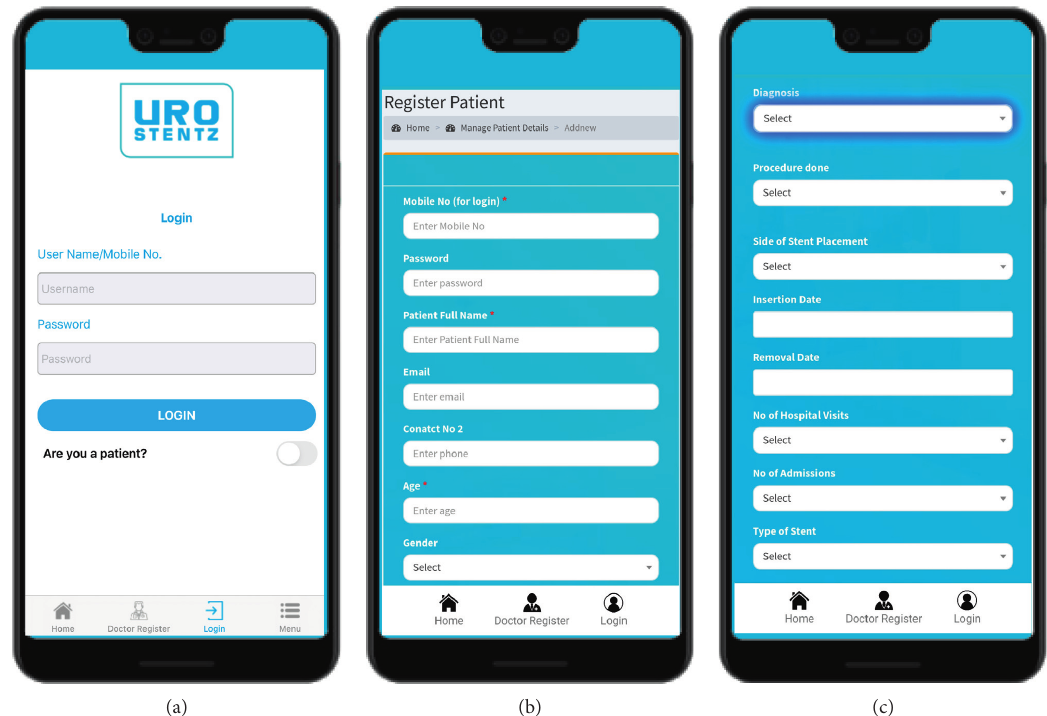
Figure 1: (a) Doctor and patient login. (b) and (c) Patient registration details including demographics, indication for stent insertion, stent size, length, date of its insertion, and scheduled removal date (reproduced with the permission of developers of the application (RAYZ CHARTERED)).